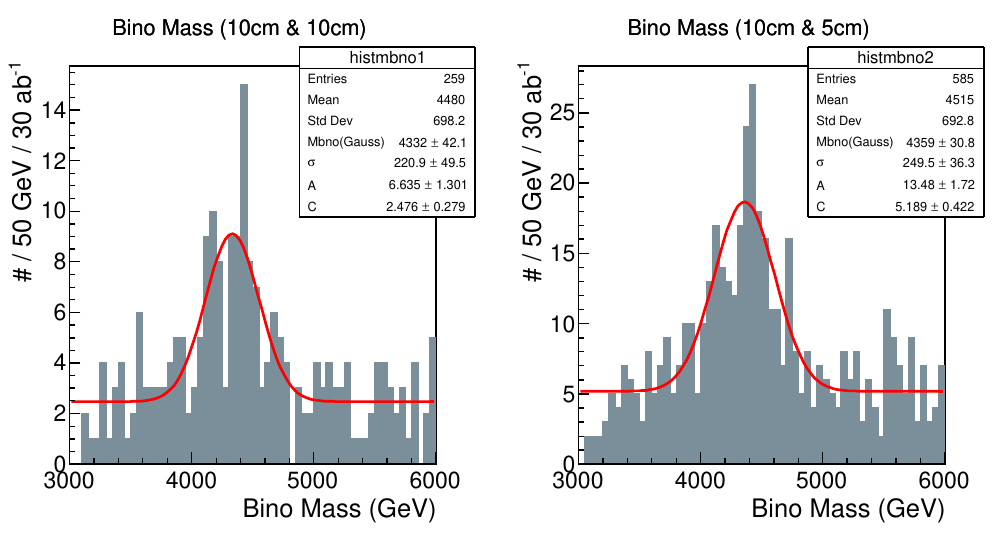
Figure 9 . Distribution of m (rec) in a single experiment with the integrated luminosity of L = 30 ab (cid:0) 1 .